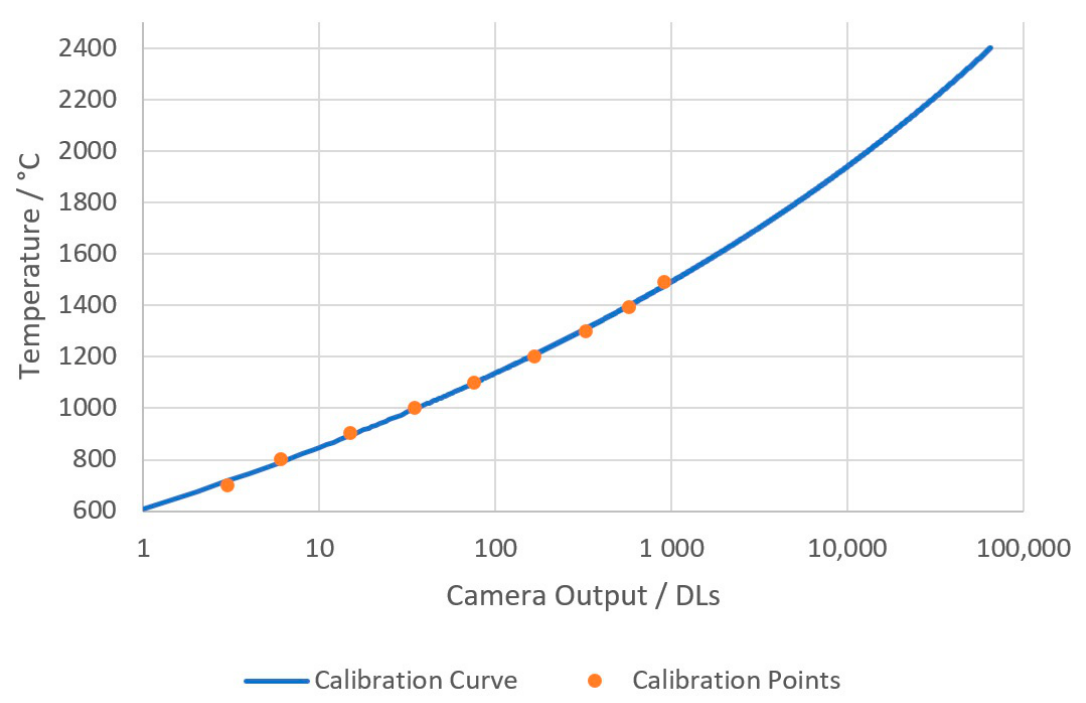
Figure 2. The temperature calibration curve with the calibration points overlaid.